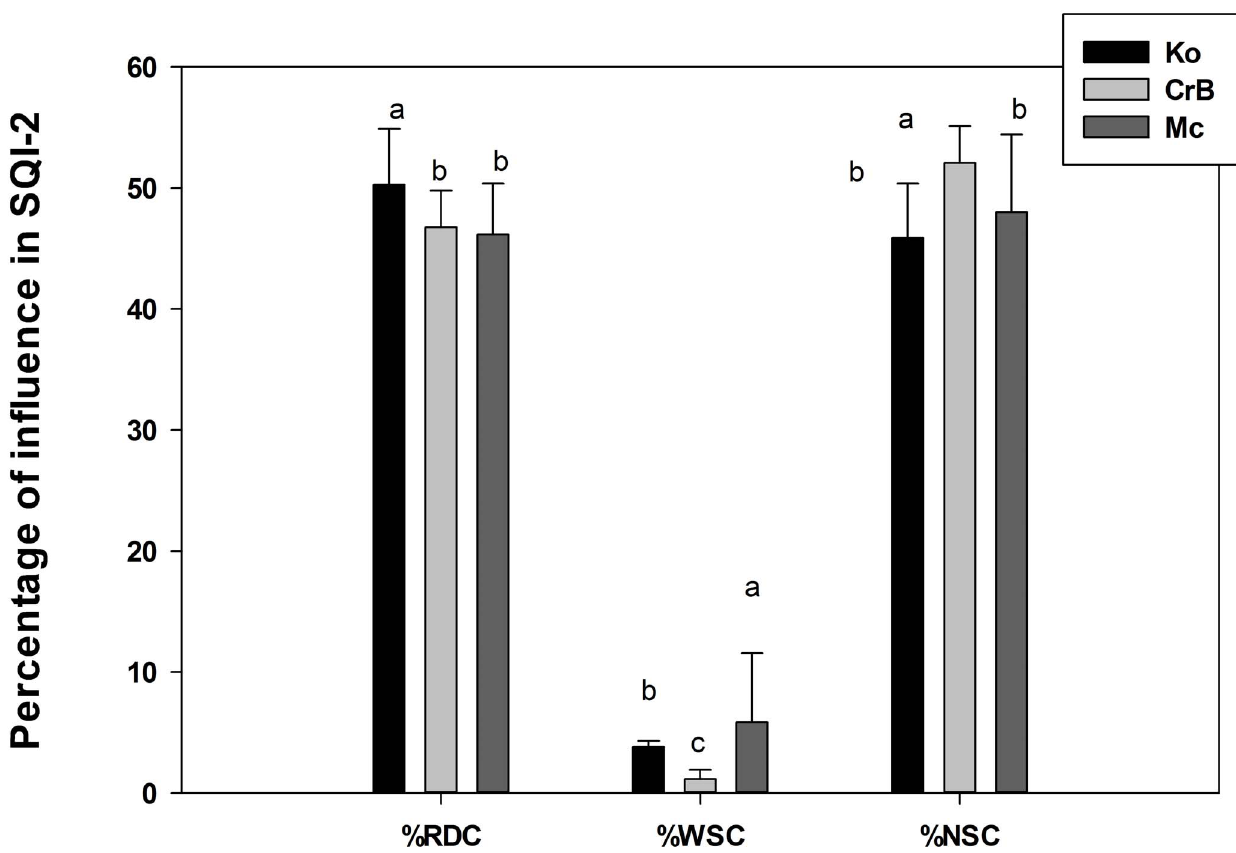
Figure 3. Percentage contribution of each soil function in SQI-2 under different soils. Different letters indicate significant differences at p , 0.05 level for particular soil function. Abbreviations: RDC: root development capacity, WSC: water storage capacity, NSC: nutrient storage capacity.